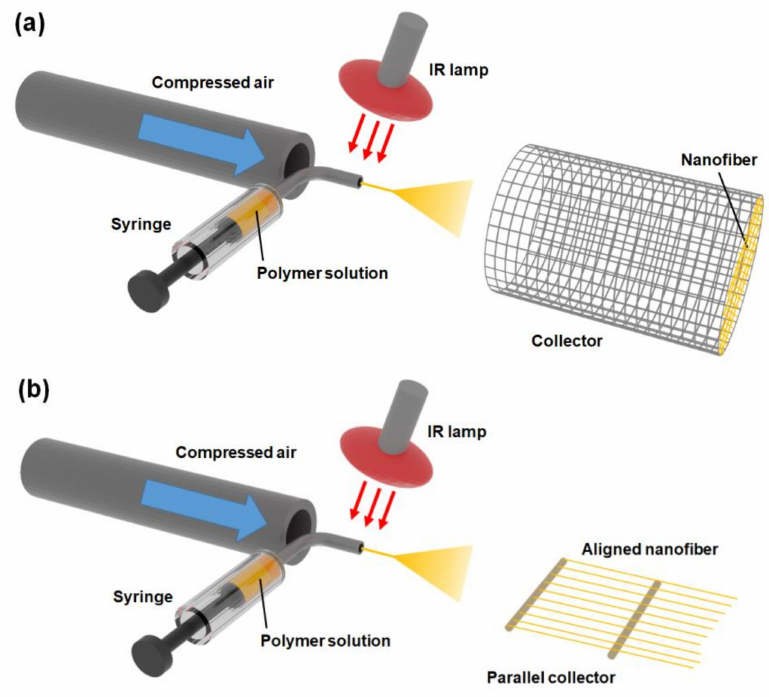
Figure 1. Schematics of ( a ) a basic solution blow spinning (SBS) setup and ( b ) a modified SBS setup for spinning aligned